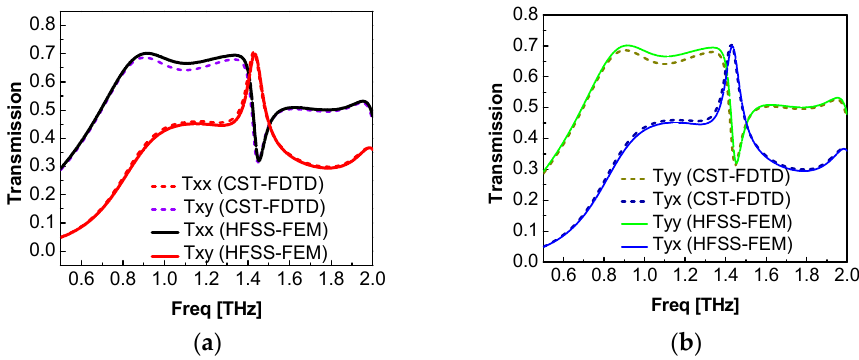
Figure 3. Transmission characteristics with incident ( a ) x-polarized ( b ) y-polarized waves.